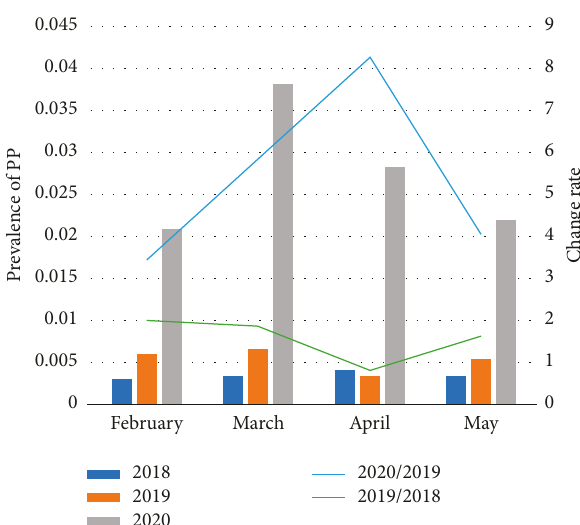
Figure 1: Prevalence and change rate in the number of female cases of new-onset precocious puberty in 22 medical institutions in different time periods with a CR of < 0.5 to identify inhibited diseases and CR of > 3 to identify stimulated diseases (CR � ratio of the prevalence of female cases of new-onset precocious puberty in different time periods).